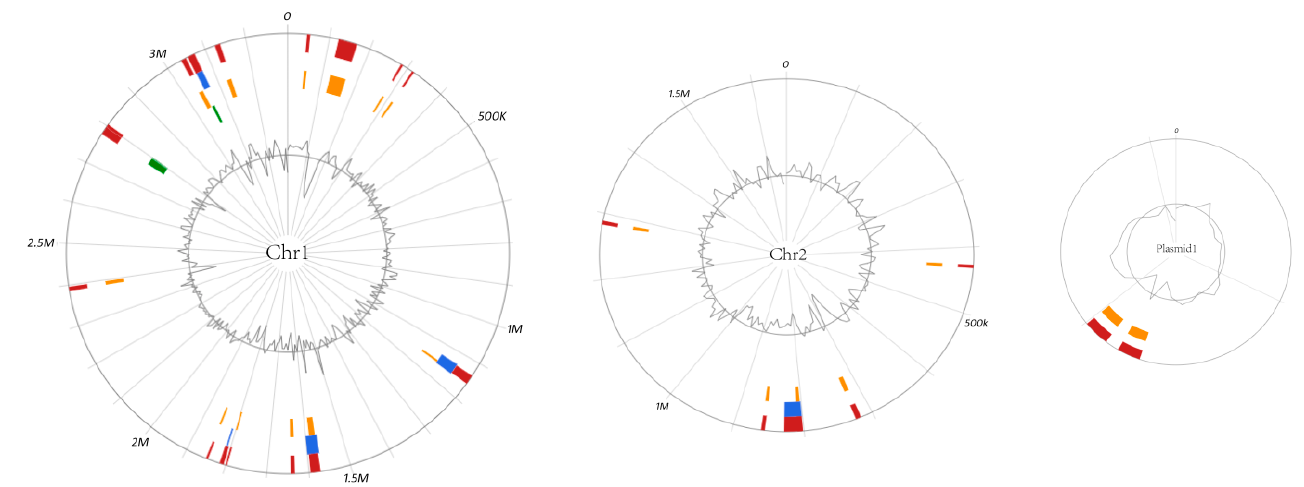
Figure 5. Genomic islands prediction in V. tubiashii FP17 by Islandviewer. The inner circle curve shows the distribution of GC content. Red indicates the integration interval of different gi prediction methods; Green means gi area predicted by islandPath-DIMOB method; Orange means gi area predicted by SIGI-HMM method; Green means gi area predicted by islandPick method.